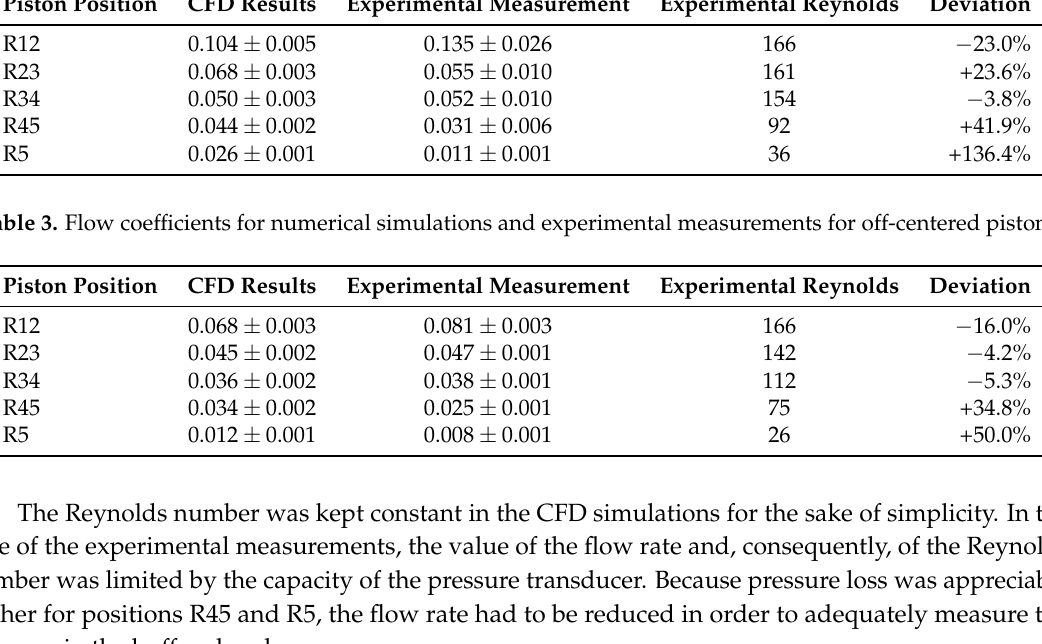
Table 2. Flow coefficients for numerical simulations and experimental measurements for centered piston. Piston Position